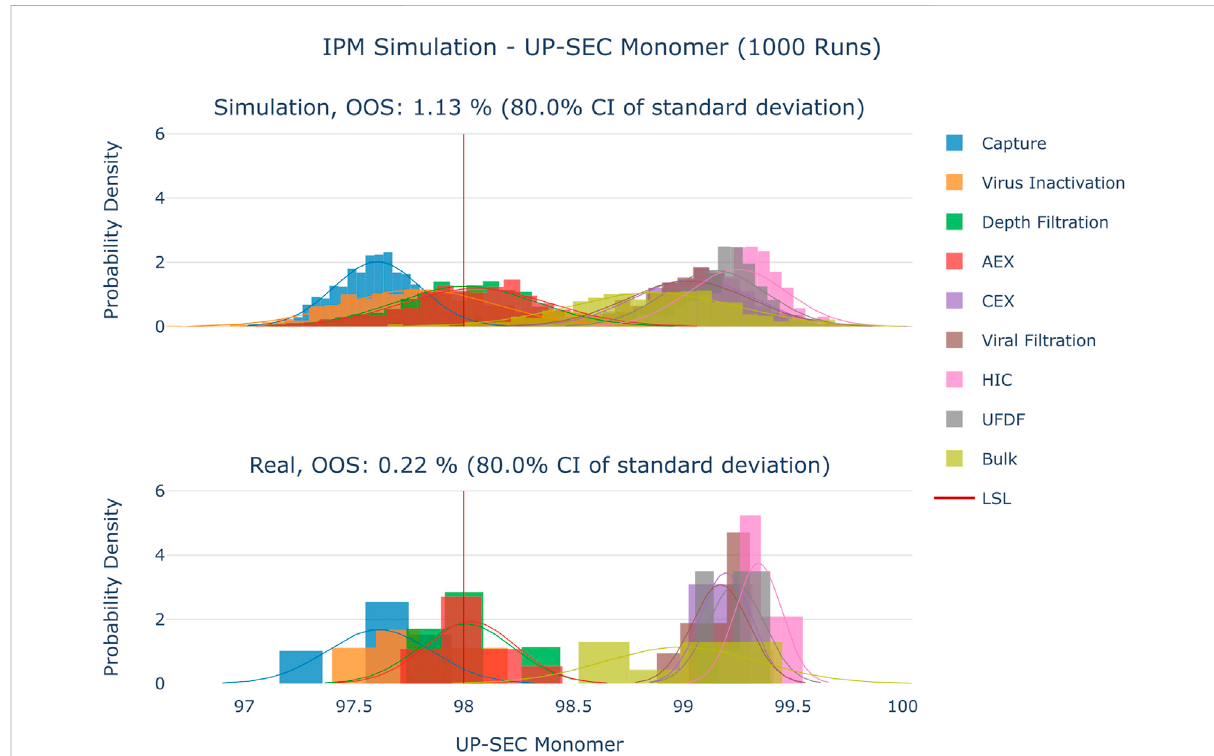
FIGURE 6 Comparison of distributions of the simulation to 10 large scale manufacturing runs for the CQA UP-SEC Monomer. The upper plot shows the simulated data based on 1000 simulations performed at set-point conditions. The lower plot shows the data from 9 large scale runs.